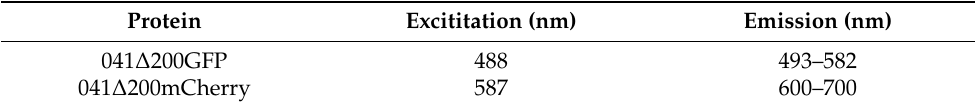
Table 2. Fluorescence parameters used for chimeric protein